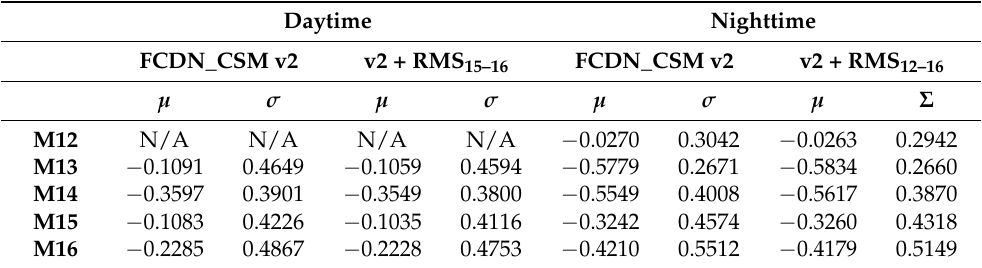
Table 9. The O-M mean biases and STDs for test data for VIIRS bands M12–M16 using FCDN_CSM v2 or FCDN_CSM v2 plus new RMS feature as clear-sky identification ( µ : O-M mean; σ : O-M standard deviation; v2+RMS: FCDN_CSM v2 plus new RMS